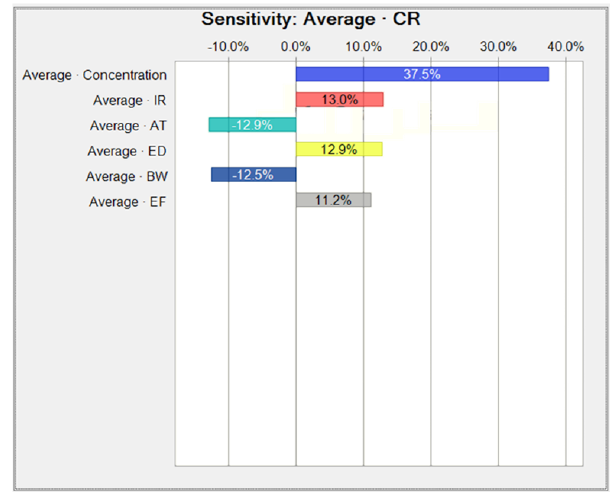
Figure A6. SA of LTCR model (children) for Pb in